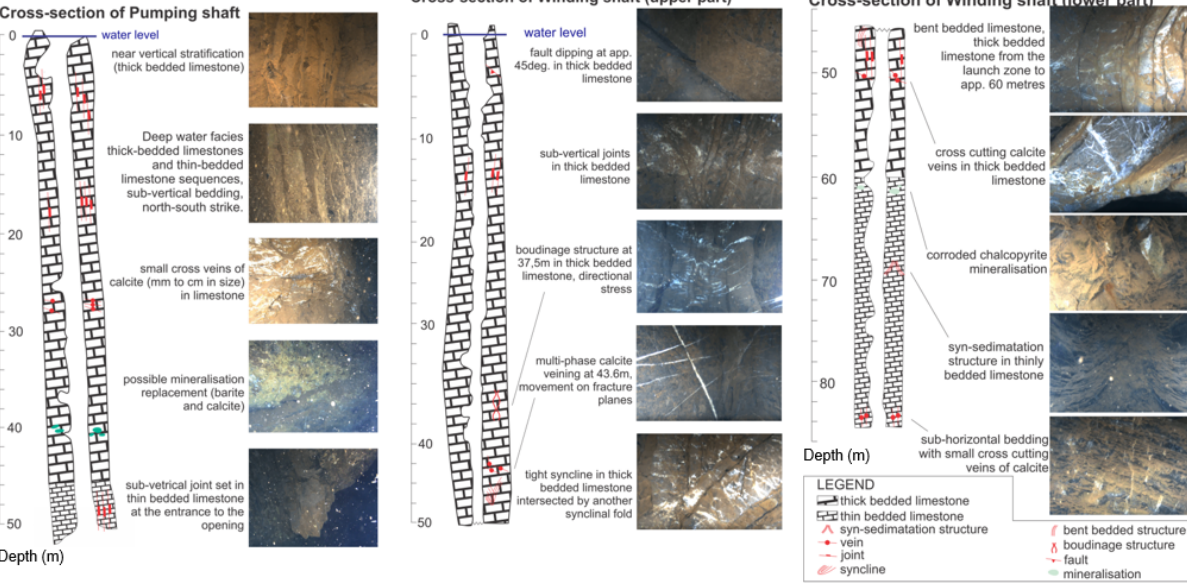
Figure 4. An example of geological cross sections, which can be built according to the robot’s data (modified from Žibret,